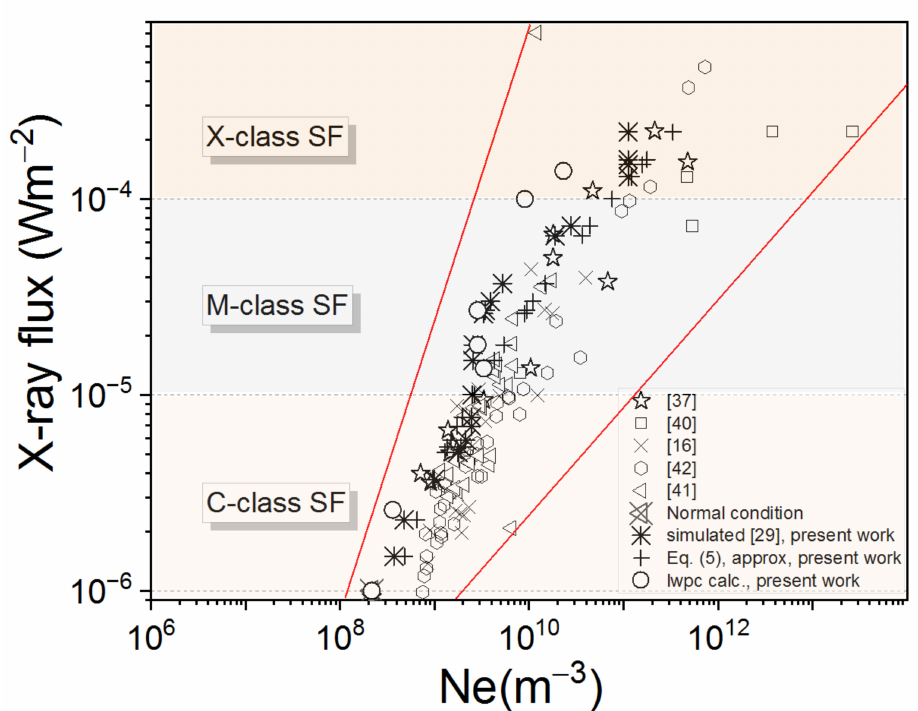
Figure 14. Electron-density data (calculated, simulated and approximated) at reference height h = 74 km and maximum of I x flux during occurrence of different class SFs. The data are compared with results from [16,37,40–42]. Area of importance is between the two red